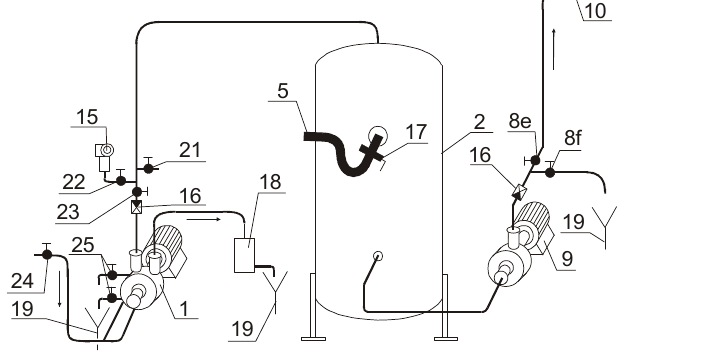
Figure 5. Vacuum station acc. Figure 2: 1-vacuum pump; 2-vacuum container; 5-vacuum pipeline with diameter of 102 mm; 8e,f-control valve; 9-water pump; 10-pressure pipeline; 15-eelectronic meter of absolute pressure; 16-non-return valve; 17-throttling valve; 18-transparent container; 19-sewerage drain; 21-vacuum container negative pressure control valve; 22, 23-vacuum pump air cut-off valve; 24-vacuum pump water cut-off valve; 25-vacuum pump working control